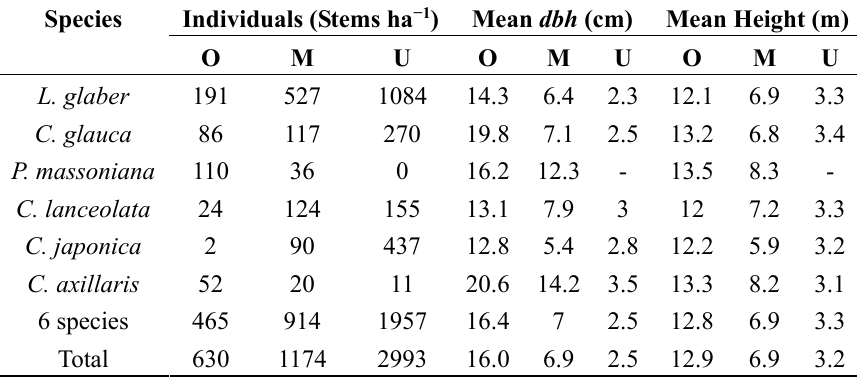
Table 3. Characteristics of six dominant species and the stand as a whole ( dbh ≥ 1 cm) at different vertical layers in a 1 ha evergreen broadleaved forest on the Dashanchong Forest Farm,